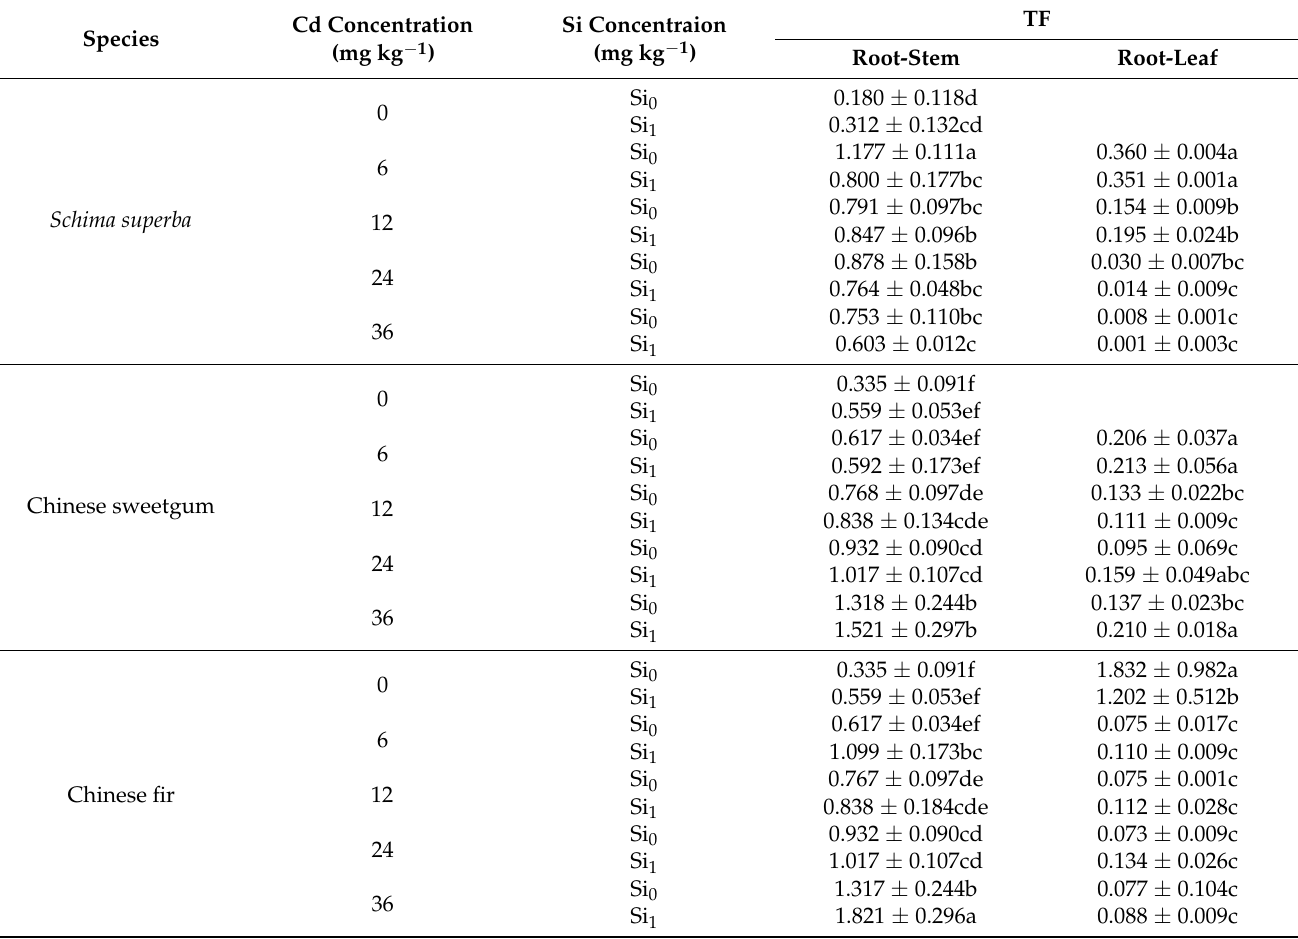
Table 3. Effects of Cd and Si on TF values of the seedlings.